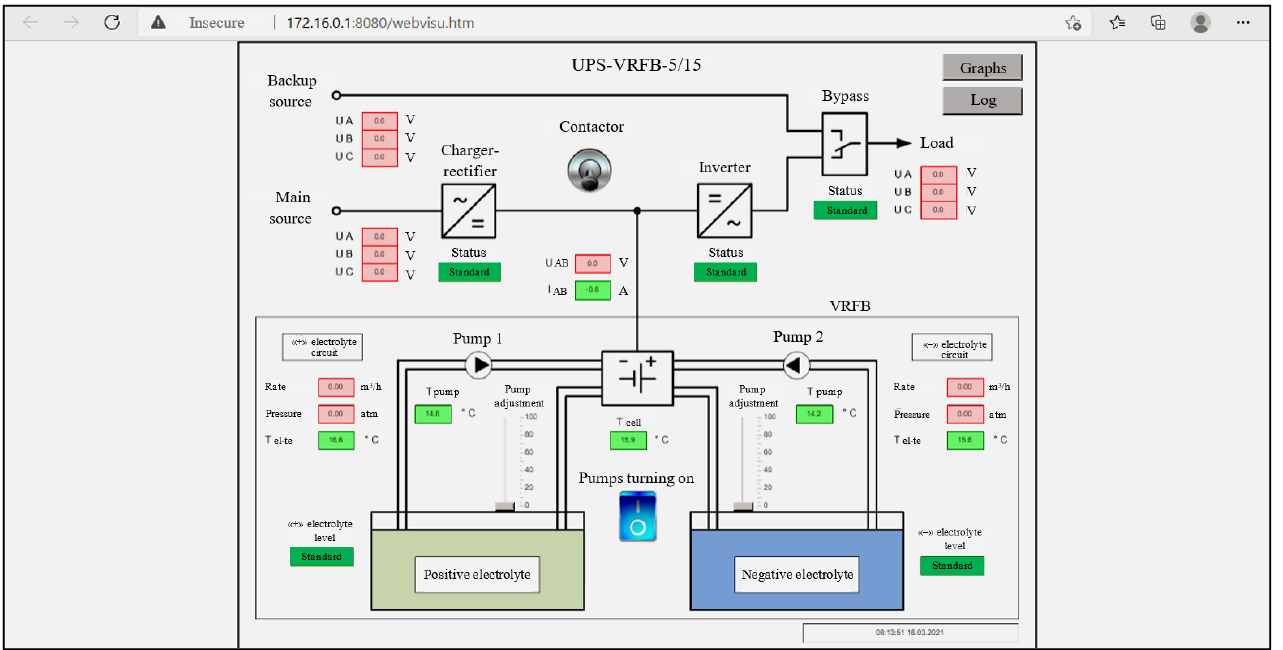
Figure 9. Main window of the computer application interface.